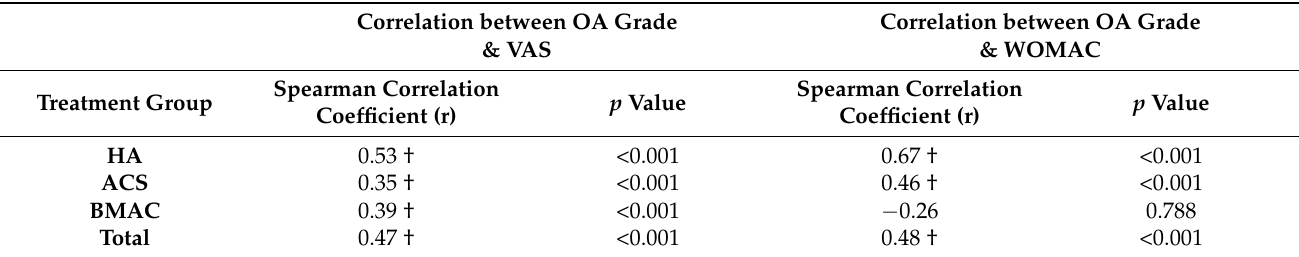
Table 3. Correlation between grade of OA and preintervention VAS and WOMAC score, respectively. Correlation between OA Grade & VAS